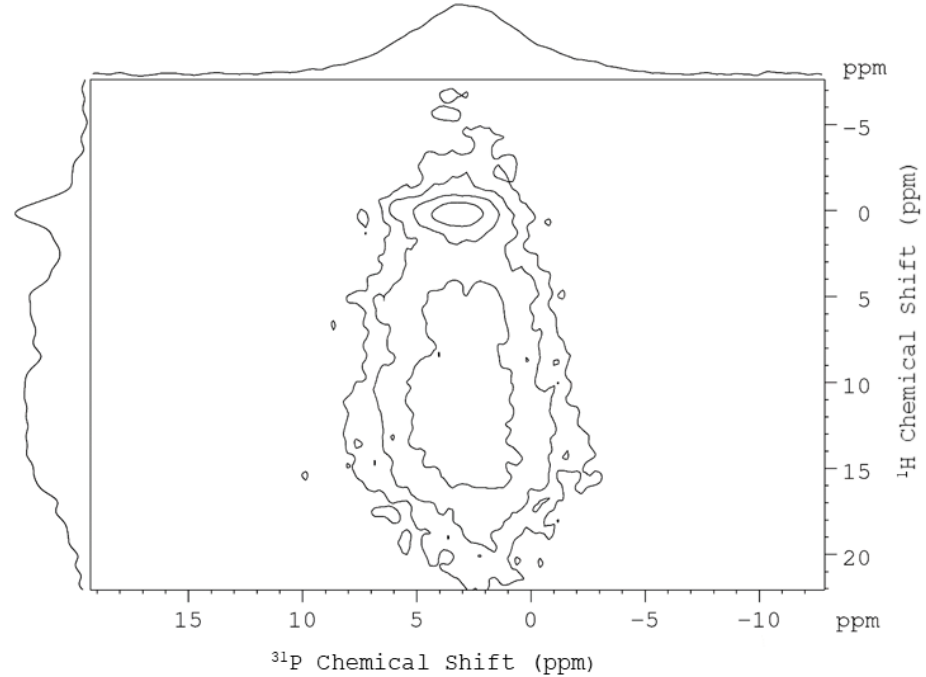
Figure 3. 31 P{ 1 H} Lee–Goldburg cross-polarization heteronuclear correlation (LG-CP HETCOR) spectrum of a typical human dentin sample. The contact time was set to 300 μ s. The signal integrals of HAp and dentin-ACP were obtained by spectral deconvolution of the projection in the 1 H dimension.